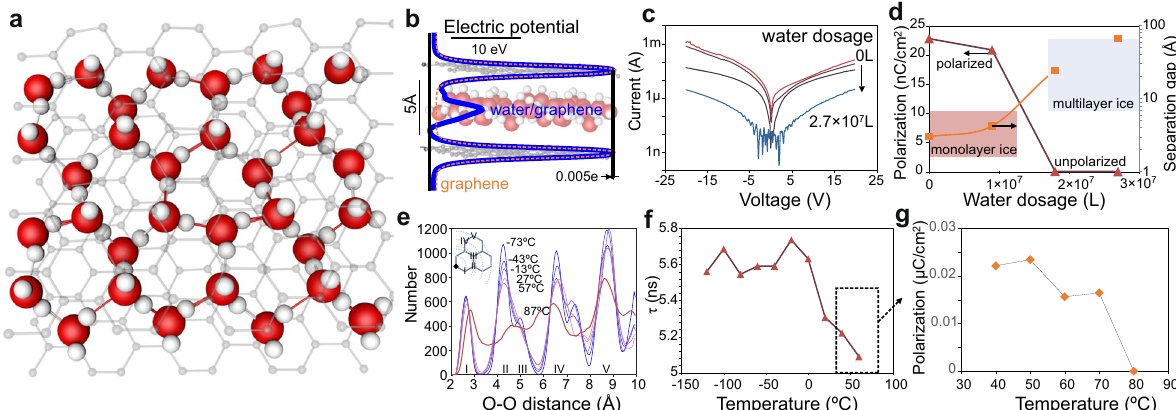
Fig. 3 Origin of ferroelectric effect. ( a ) DFT simulation results of con fi ned water relaxed structure displaying ice XI con fi guration, ( b ) electrostatic potential distribution (relative to origin) along the z-axis of pristine graphene and graphene/ice structure with overlaid 3D image of relaxed structure ( c ) current-voltage characteristics of the device under different amounts of water coverage, ( d ) tunneling distance between electrodes and polarization as a function of water coverage, ( e ) bond distance histogram of structures relaxed at different temperatures through molecular dynamics simulation, ( f , g ) Temperature dependence of ( f ) high-frequency relaxation time constant and ( g ) PUVD